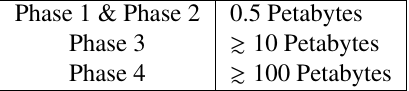
Table 1. Storage requirements for each phase of the Project 8